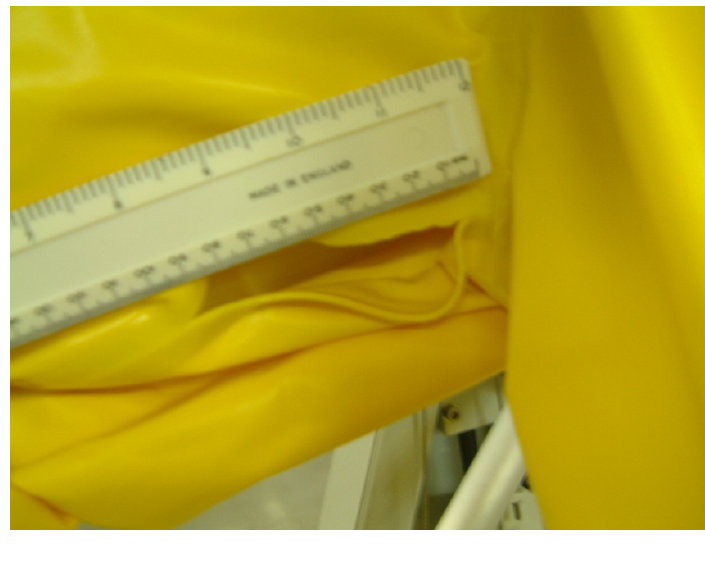
Figure 4. A cut in the inner thigh area of the leg of suit